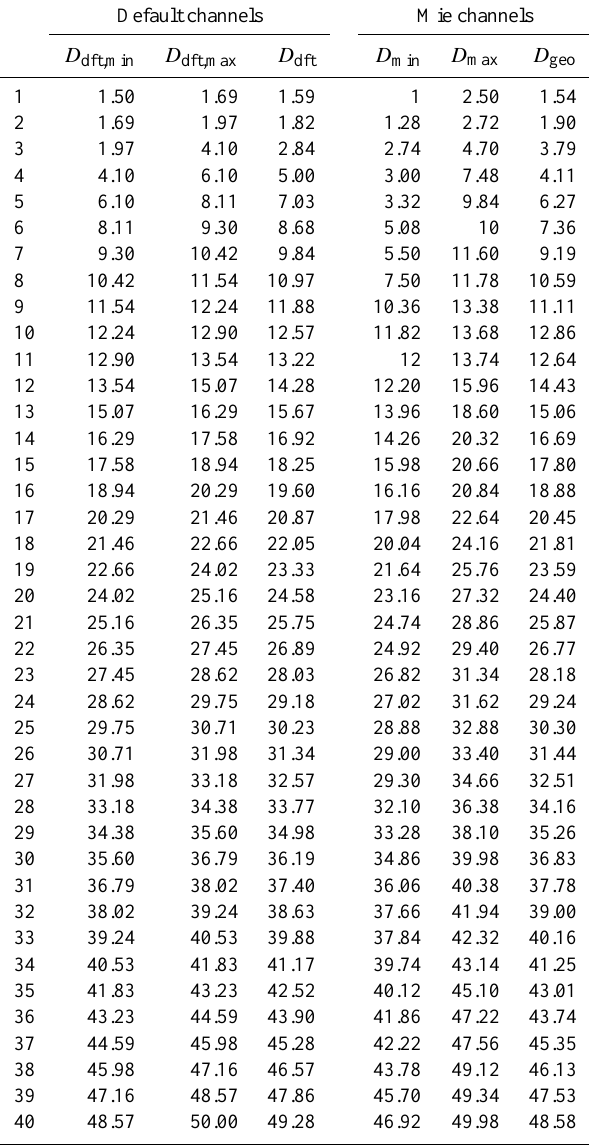
Table 2. Channel range of the default (ranging from D dft,min to D dft,max with a geometric mean diameter D dft ) and the new Mie channels (ranging from D min to D max with a geometric mean di- ameter D geo ). Values are given in units of